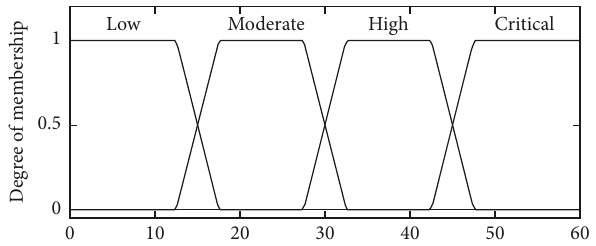
Figure 8: Input variable membership function-oil quality Factor